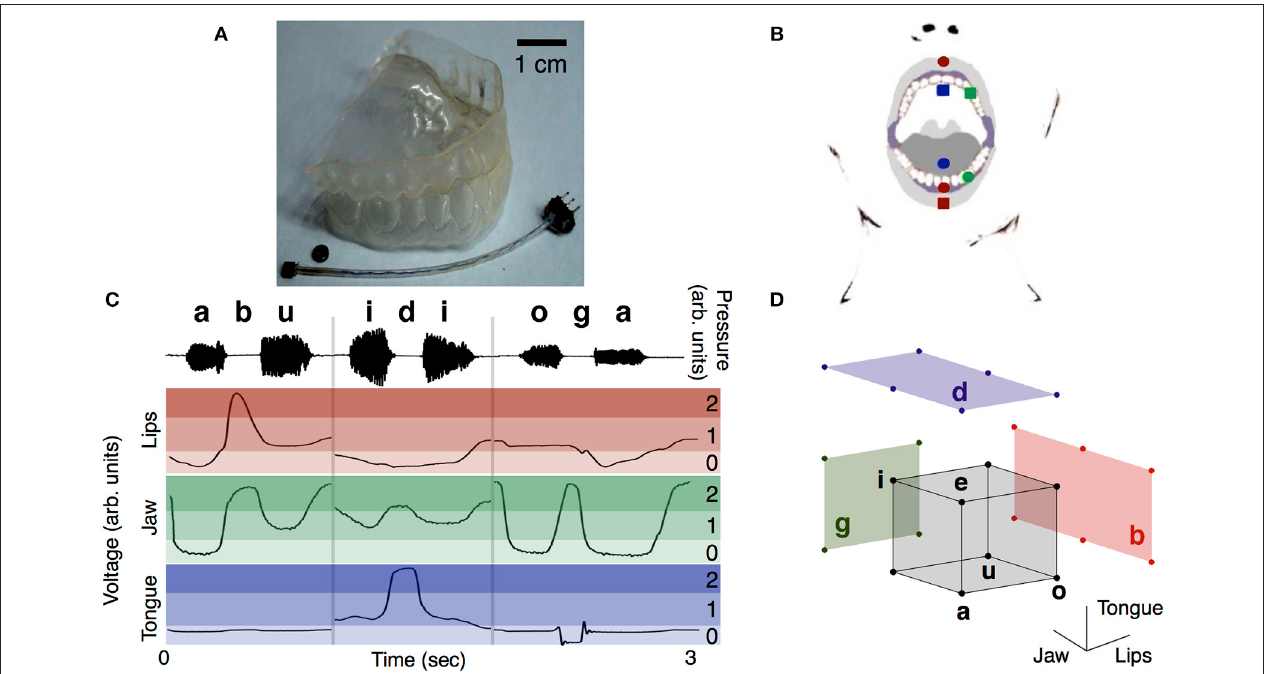
FIGURE 1 | Discrete coordinates are extracted from the time traces of three detectors in the oral cavity. (A) The dental plastic replica with a magnet and a Hall-effect transducer. (B) Sketch of the position of the set of transducers (squares) and magnets (circles) in the oral cavity. In green the set tracking the jaw -the magnet and transducer were glued to the molds at the upper and lower left canines, respectively. In blue the set tracking the tongue -the transducer fixed to the mold at the palate and the magnet to the tip of the tongue. In red the set tracking the lips—the transducer fixed in the center of the lower lip, one magnet glued to the lower mold, between the lower central incisors, and another in the center of the upper lip. Figure adapted from Assaneo et al. (2013). (C) Discretization of the signals. Upper panel: VCV phonemes and sound wave. Lower panel: time traces of the transducers signals during the vocalizations. The intensity of the shaded regions differentiates the discrete states. (D) States of vowels and consonants in the discrete motor space. The corners of the gray cube represent the vowels and the colored walls de different